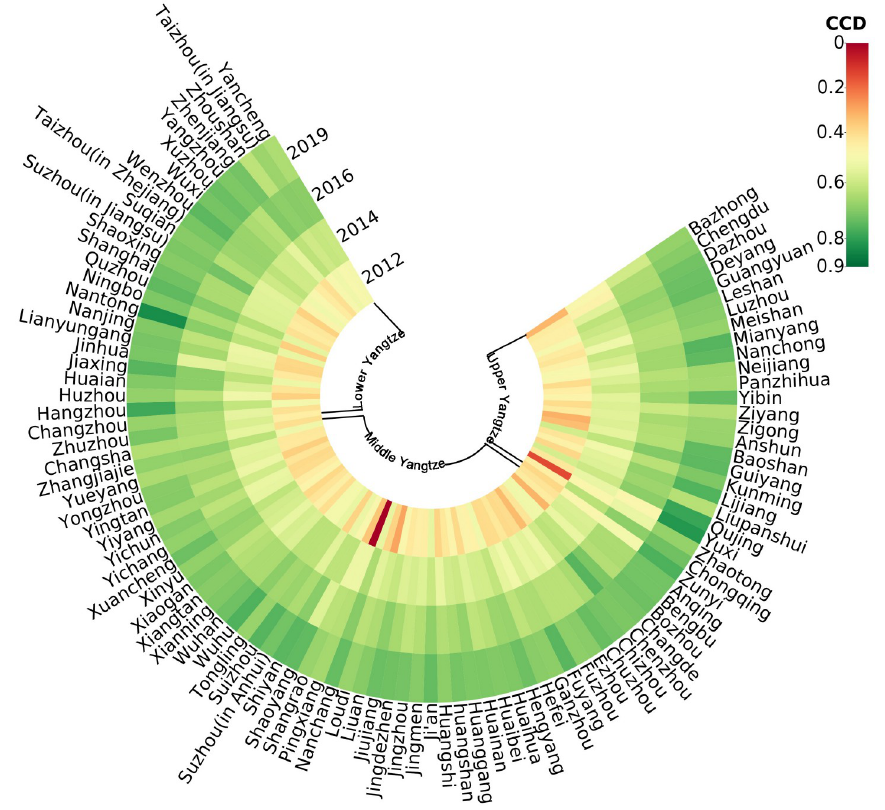
Fig 5. Spatial distribution of the CCD.